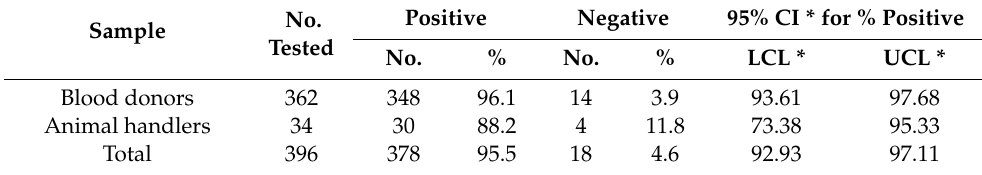
Table 1. The prevalence of TTV in Jordanian blood donors and animal handlers.